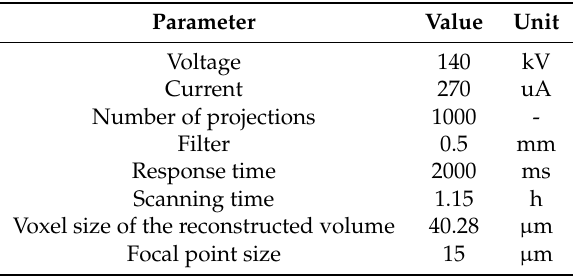
Table 2. Detailed parameters of X-ray scanning.